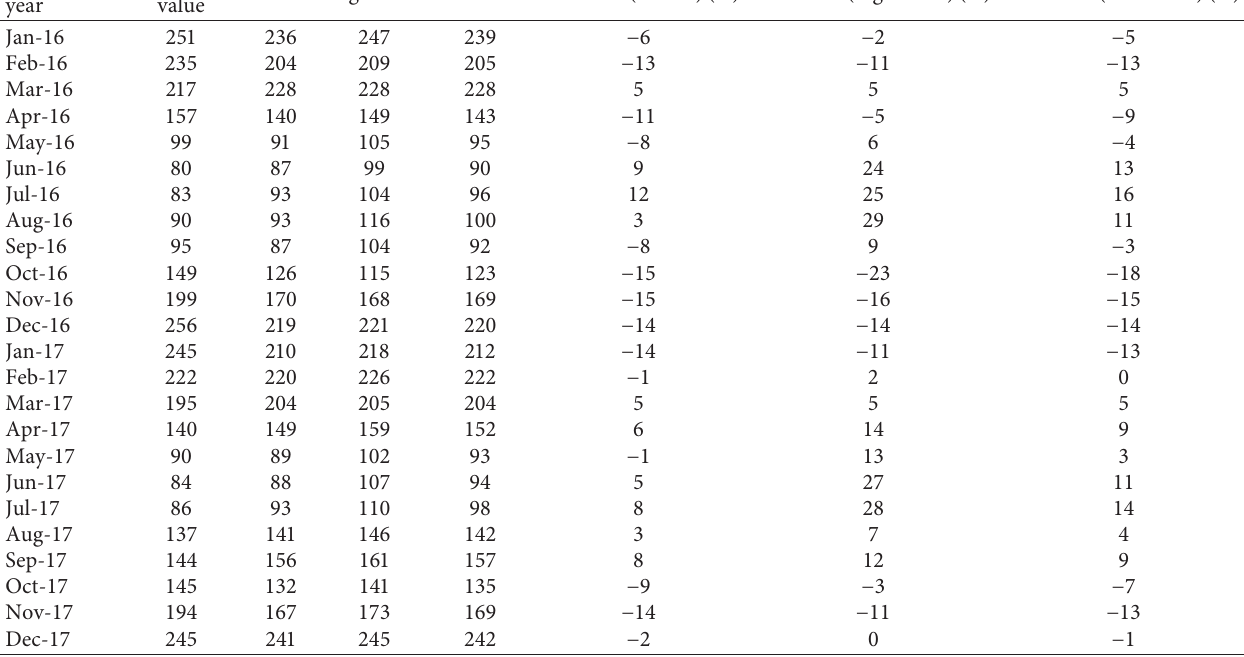
Table 12: Error rate of the model.